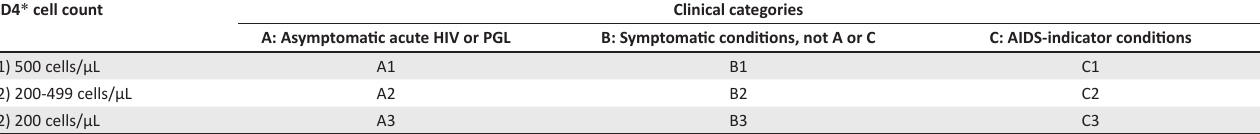
TABLE 2-A1: CDC classification system for HIV-infected adults and adolescents. CD4 * cell count Clinical